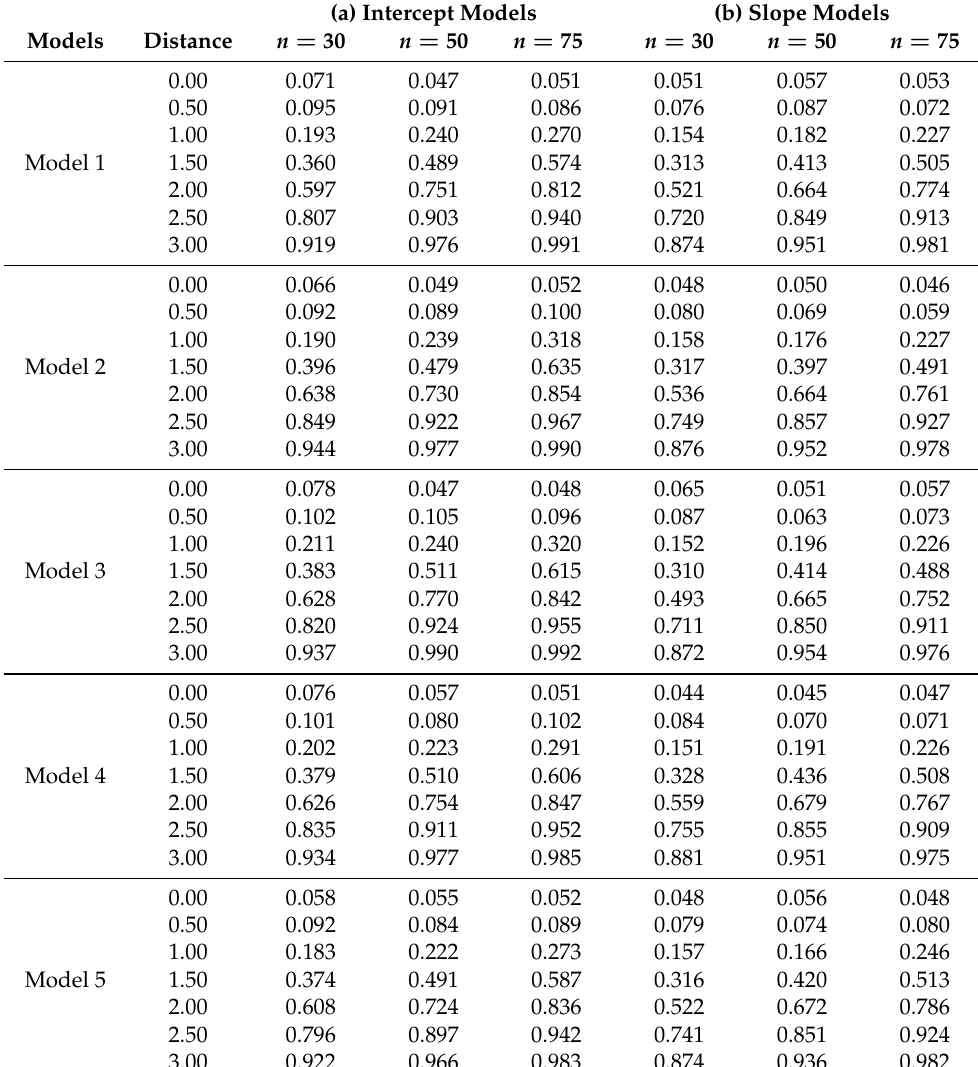
( τ ) for intercept models and slope models with τ = 0.50. hs